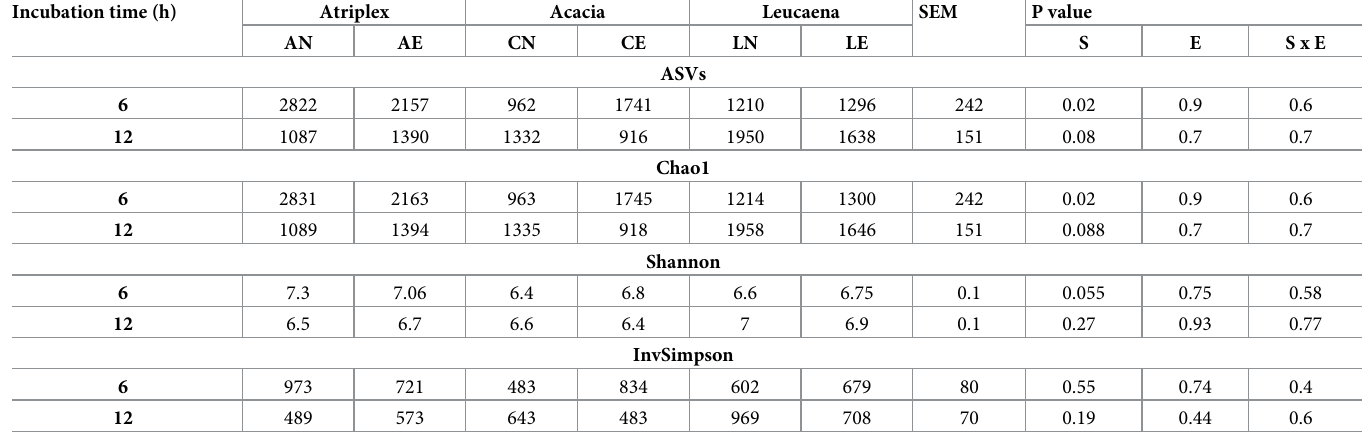
non-extracted plants (Table 3). Alpha diversity analysis showed a significant effect of plant type on ASVs number and Chao1 index at 6h, whenever CN showed lower diversity and AN had higher diversity (Table 3). In addition, incubation time did not reveal any effect on the diversity indices (S1 File). Beta diversity analysis was calculated and visualized using principal coordinate analysis based on the Bray–Curtis distances. The analysis revealed that bacterial communities were not distinctively separated by neither plant types nor phenol extraction (Fig 1).